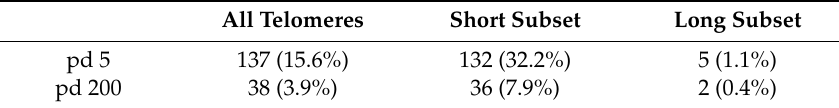
Table 2. Number of telomeres signals below detection